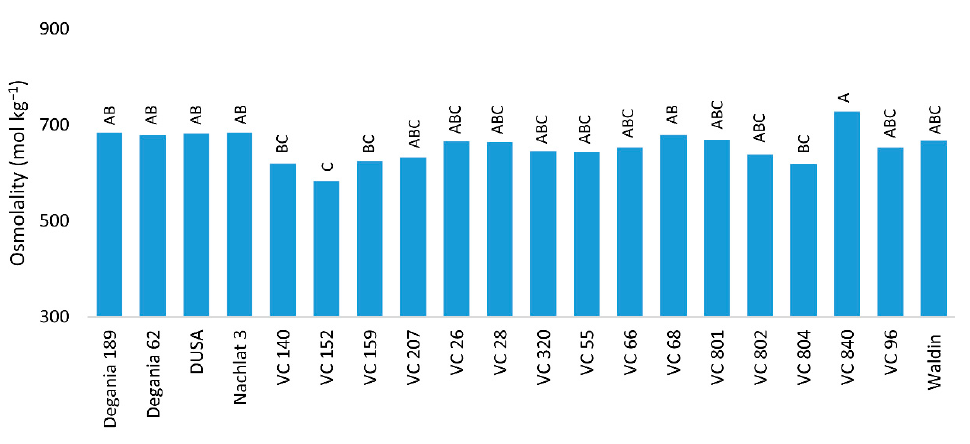
Figure 3. Leaf osmolality of ‘Hass’ avocado trees grafted onto various rootstocks, after 18 months of salinity exposure. Different letters represent significant ( p ≤ 0.05) differences between rootstocks. SD values are presented in Table S1.